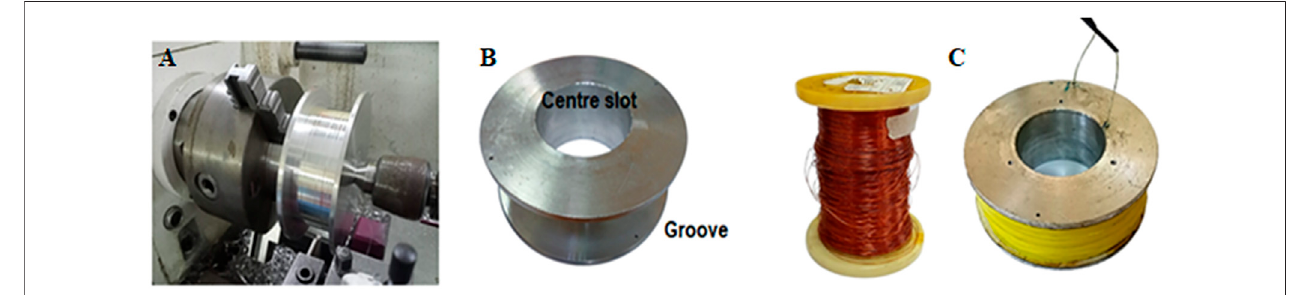
FIGURE 2 | Fabrication of the electromagnetic coil (A) Coil bobbin machining process, (B) Machined part of the coil bobbin, and (C) End product of the electromagnetic coil by winding the copper wire around the